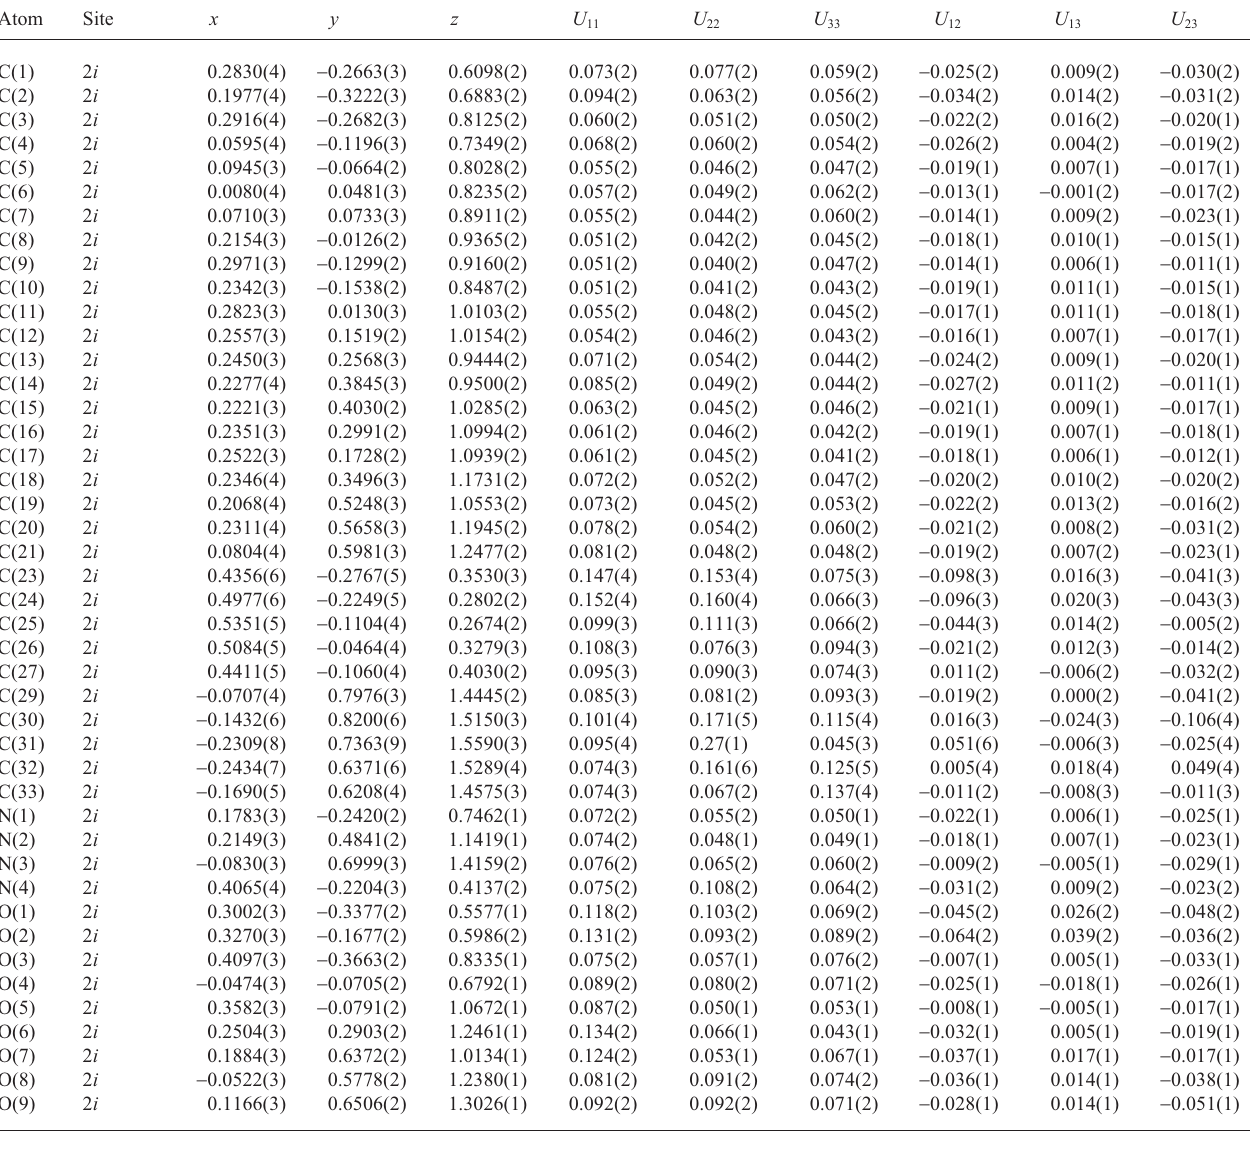
Table 3. Atomic coordinates and displacement parameters (in Å 2 )